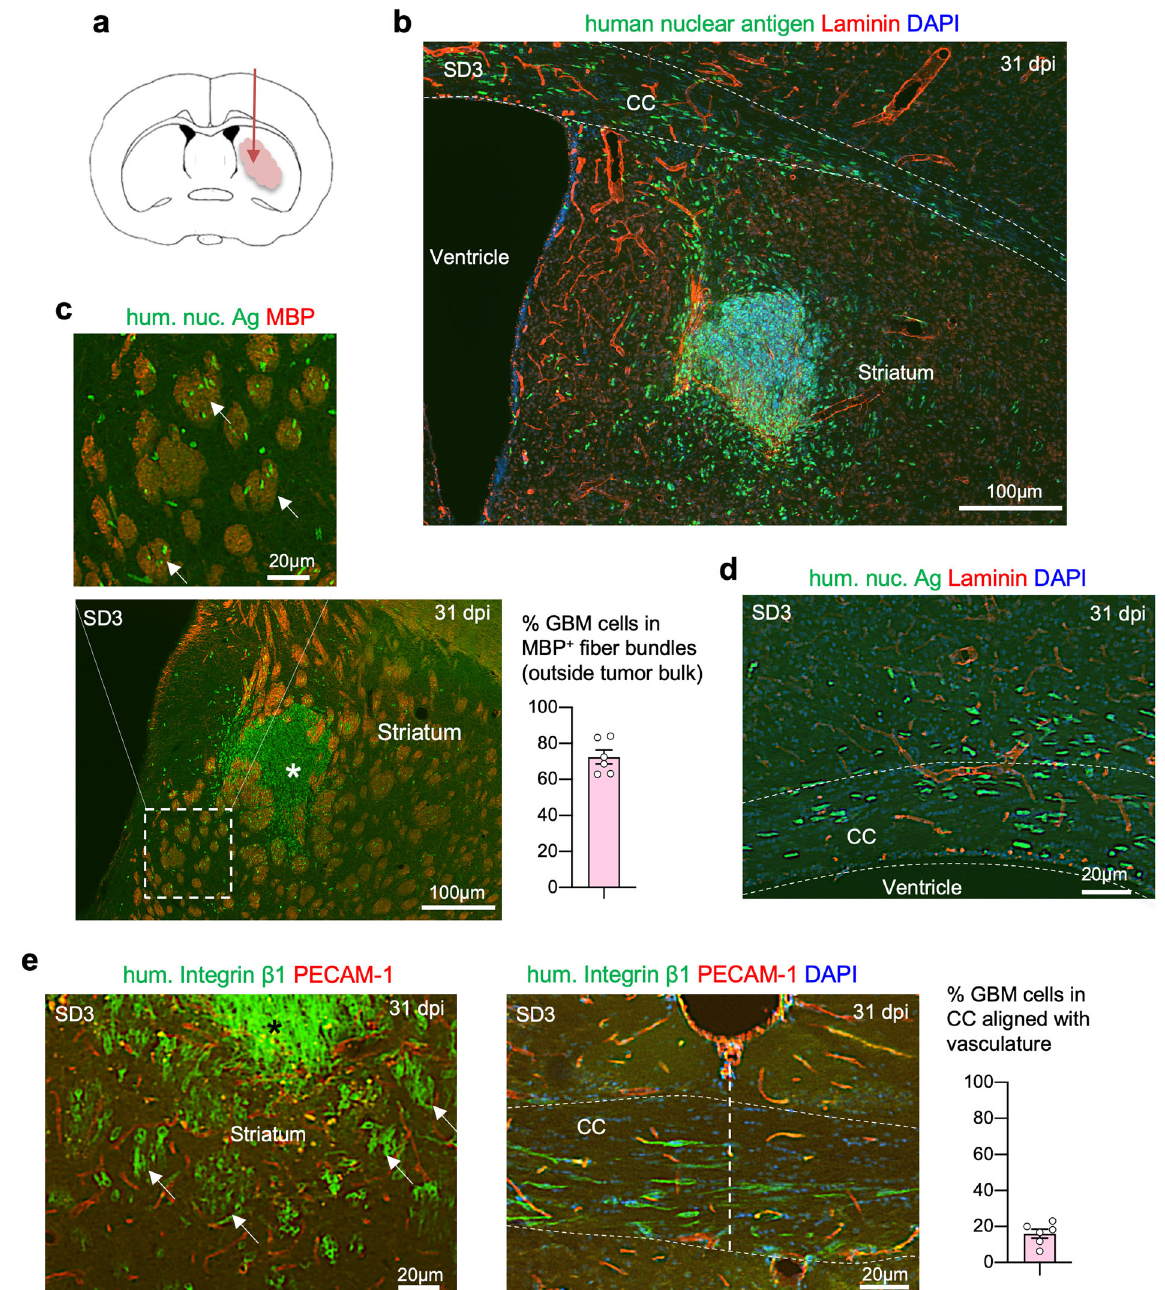
Fig. 1 Diffuse GBM in fi ltration along axon fi ber tracts in intracranial GSC transplants. a Diagram of orthotopic transplantation of patient-derived GSCs into the striatum of SCID mouse host. All images in this fi gure panel are from GSC line SD3 at 31 days post implantation (dpi). b Immuno fl uorescence (IF) image of coronal brain section with SD3 GSC transplant at 31 dpi, showing diffuse in fi ltration of tumor cells expressing human nuclear antigen (hum. nuc. Ag) in the striatum and along corpus callosum (CC, outlined by dashed lines). Laminin IF highlights the basal lamina ensheathing blood vessels. c Enlarged IF image shows a clear preference of invading GBM cells (hum. nuc. Ag + ) for striatal axon fi ber bundles (arrows), highlighted by IF for myelin basic protein (MBP). Numerous individual tumor cells had migrated away from tumor bulk (asterisk). Quanti fi cation indicates that in areas outside tumor bulk, greater than 70% of in fi ltrating cells are found in MBP + fi ber bundles ( n = 6 fi elds from three animals; mean ± SEM). d IF image of the ipsilateral area of SD3 GSC transplant shows GBM cells invading along fi ber tracks of the corpus callosum (CC). Note the orientation of elongated nuclei of the invading GBM cells aligned with axon fi ber trajectory, but not with blood vessel axis (laminin + ). e IF images of ipsilateral striatum (left) and CC at the midline (right) from brain transplanted with SD3 GSCs. Tumor cells stained for human integrin β 1, which highlights cell surfaces, show diffuse dissemination within striatal axon fi ber bundles (arrows) surrounded at the periphery by microvasculature (PECAM-1 + ). Note that the orientation of striatal fi ber bundles and adherent GBM cells appeared perpendicular to the coronal plane. Also note the fusiform shape of the invading GBM cells in the CC, with cell axes aligned with axon trajectory, but not with microvasculature. Quanti fi cation on the right indicates the percentage of cells in the corpus callosum that are aligned with vessels ( n = 6 fi elds from three animals; mean ± SEM).